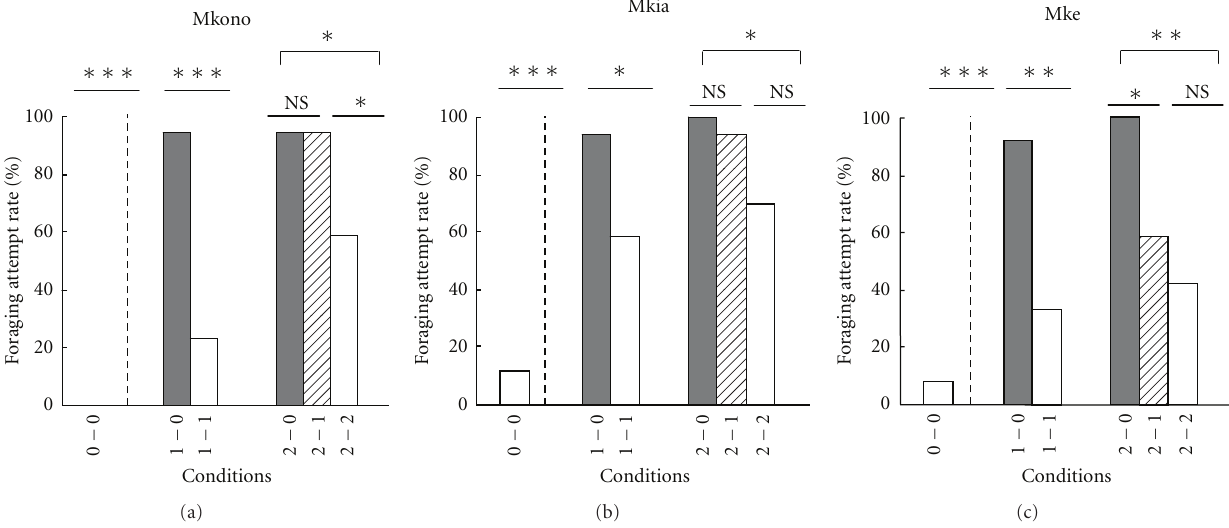
Figure 4: “Foraging attempt” rates for one-step subtraction. The “foraging attempt rates” were expressed as the percentage of “attempt made” trials over the total number of trials in each condition for each subject. The number of sessions completed was 17 for Mkono and Mkia, and 12 for Mke. ∗ ∗ ∗ : P < . 001, ∗∗ : P < . 01, ∗ : P < . 05. P values are two tailed. Fisher’s exact test was conducted only once between the “2 − 1” and “2 − 2” conditions for testing di ff erences among the three conditions: “2 − 0”, “2 − 1”, and “2 − 2” for Mkono, since the frequencies for the “2 − 0” and “2 − 1” conditions were identical. The di ff erence between the “2 − 0” and “2 − 2” conditions becomes marginally significant when the threshold is set at 2.5% for multiple comparison for Mkia. The di ff erence between the “2 − 0” and “2 − 1” conditions becomes marginally significant when the threshold is set at 2.5% for multiple comparison for